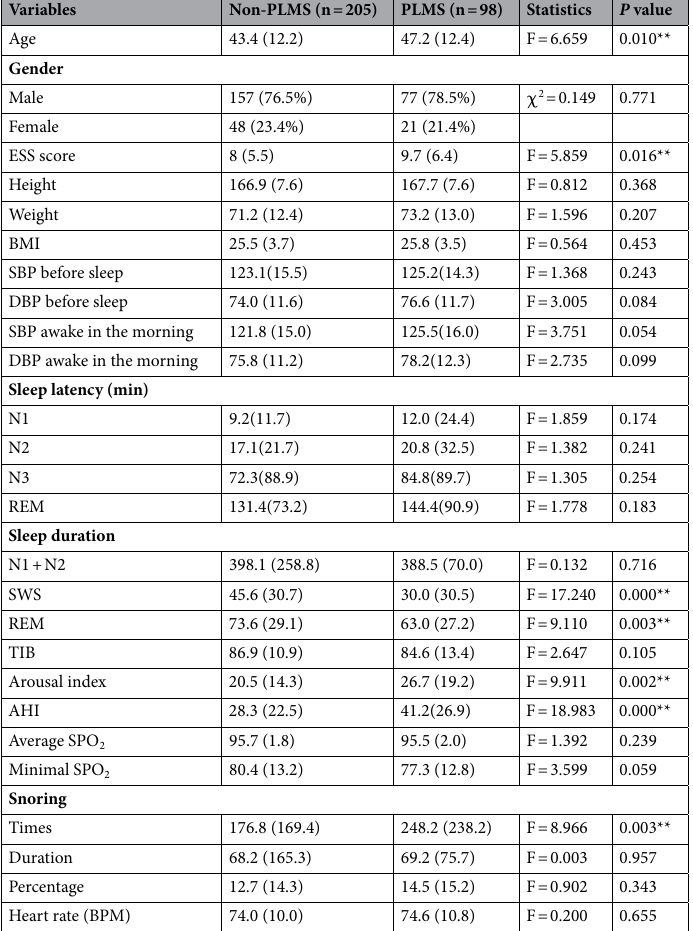
Table 1. Univariate analysis of differences between OSAS patients with PLMS and without PLMS. ESS Epworth sleepiness scale, BMI body mass index, SBP systolic blood pressure, DBP diastolic blood pressure,